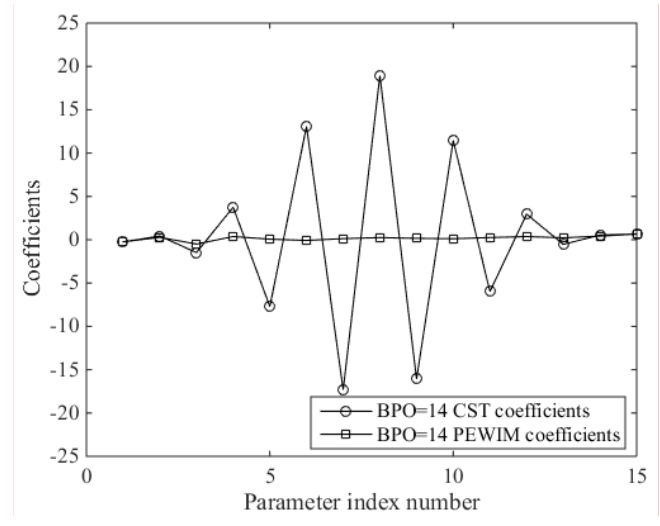
Figure 12. Comparison between the CST method and the PEWI method of the lower airfoil.